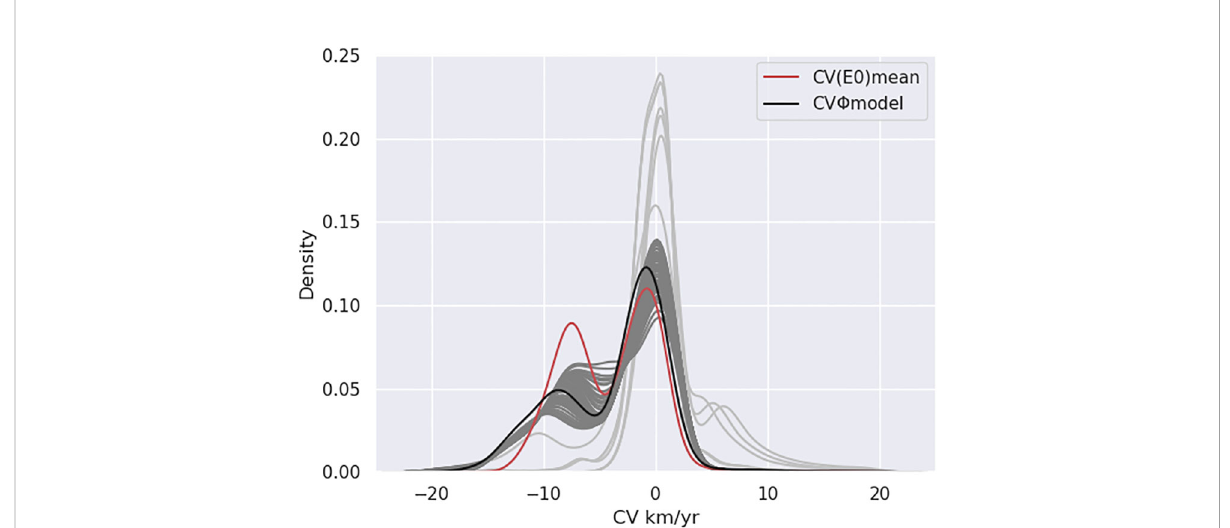
FIGURE 6 Pdf of climate velocities of the metabolic index at 200m. For CV F model (black) and CV(E 0 ) mean (red). For the 71 species in grey with positive E 0 (dark grey) and negative E 0 (light grey).